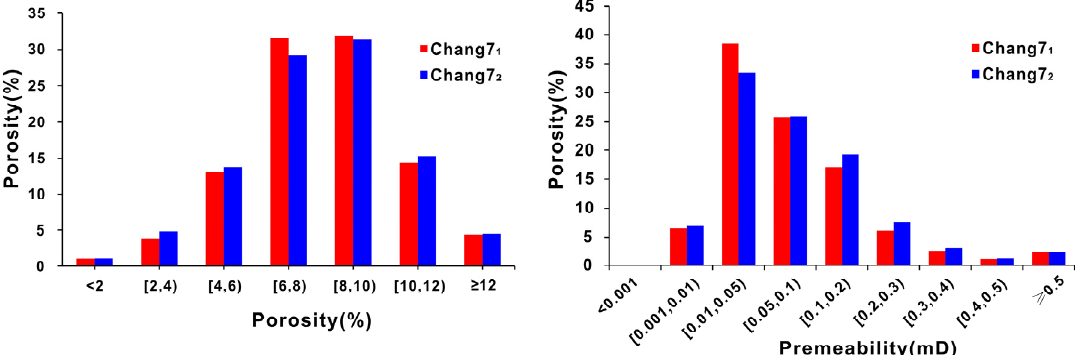
Figure 3. Physical properties of Chang 7 1-2 shale oil reservoirs.